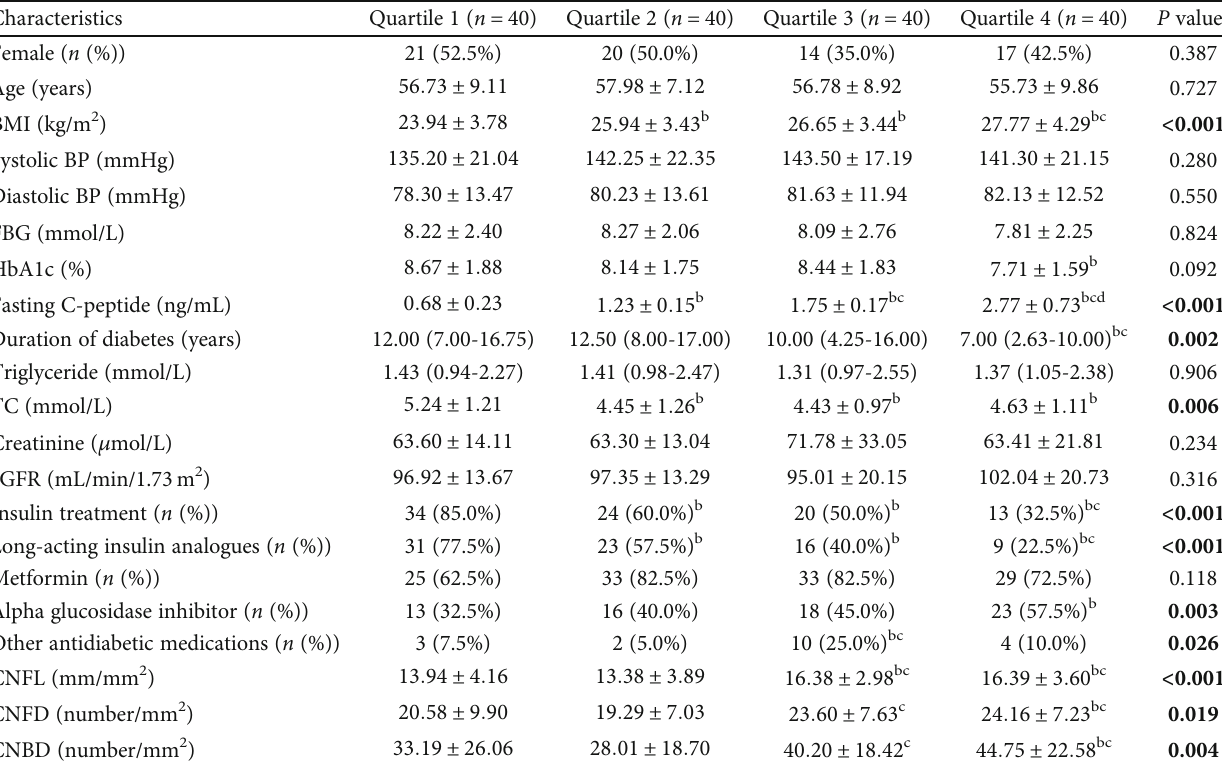
Table 1: Characteristics of participants by fasting C-peptide